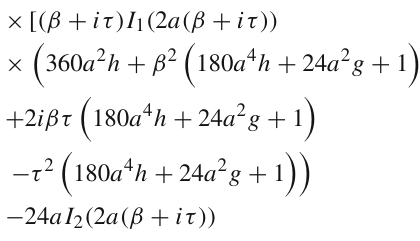
Fig. 27 Time variation of SFF for different N. Here we shift reference axis[SFF] to SFF | τ =